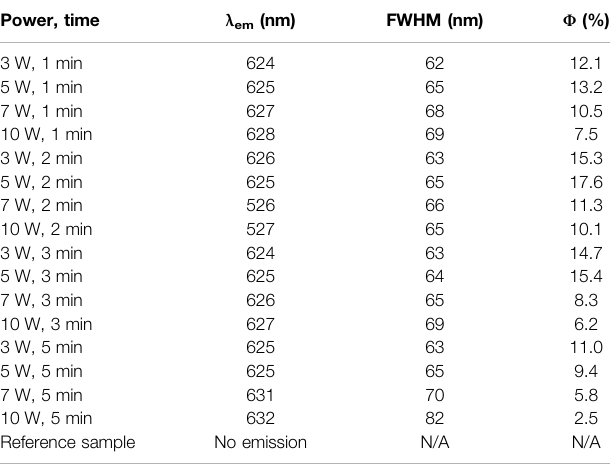
TABLE1| PhotophysicalparametersofAuNCsuponvariousmicrowaveradiation powder and reaction time. Power, time